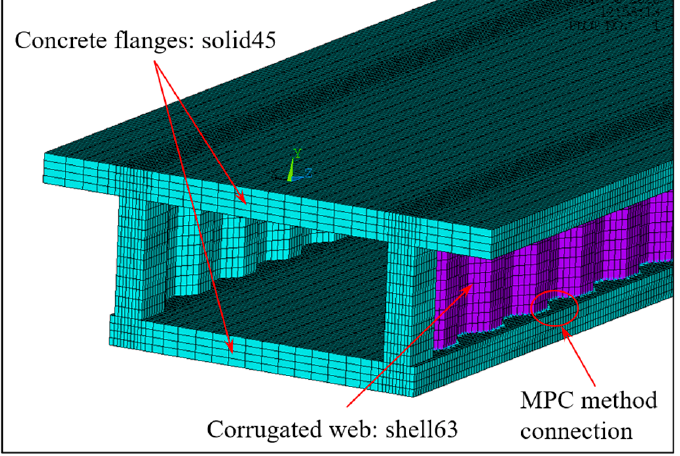
Figure 10. 3D finite element model of CBG-CSWs.